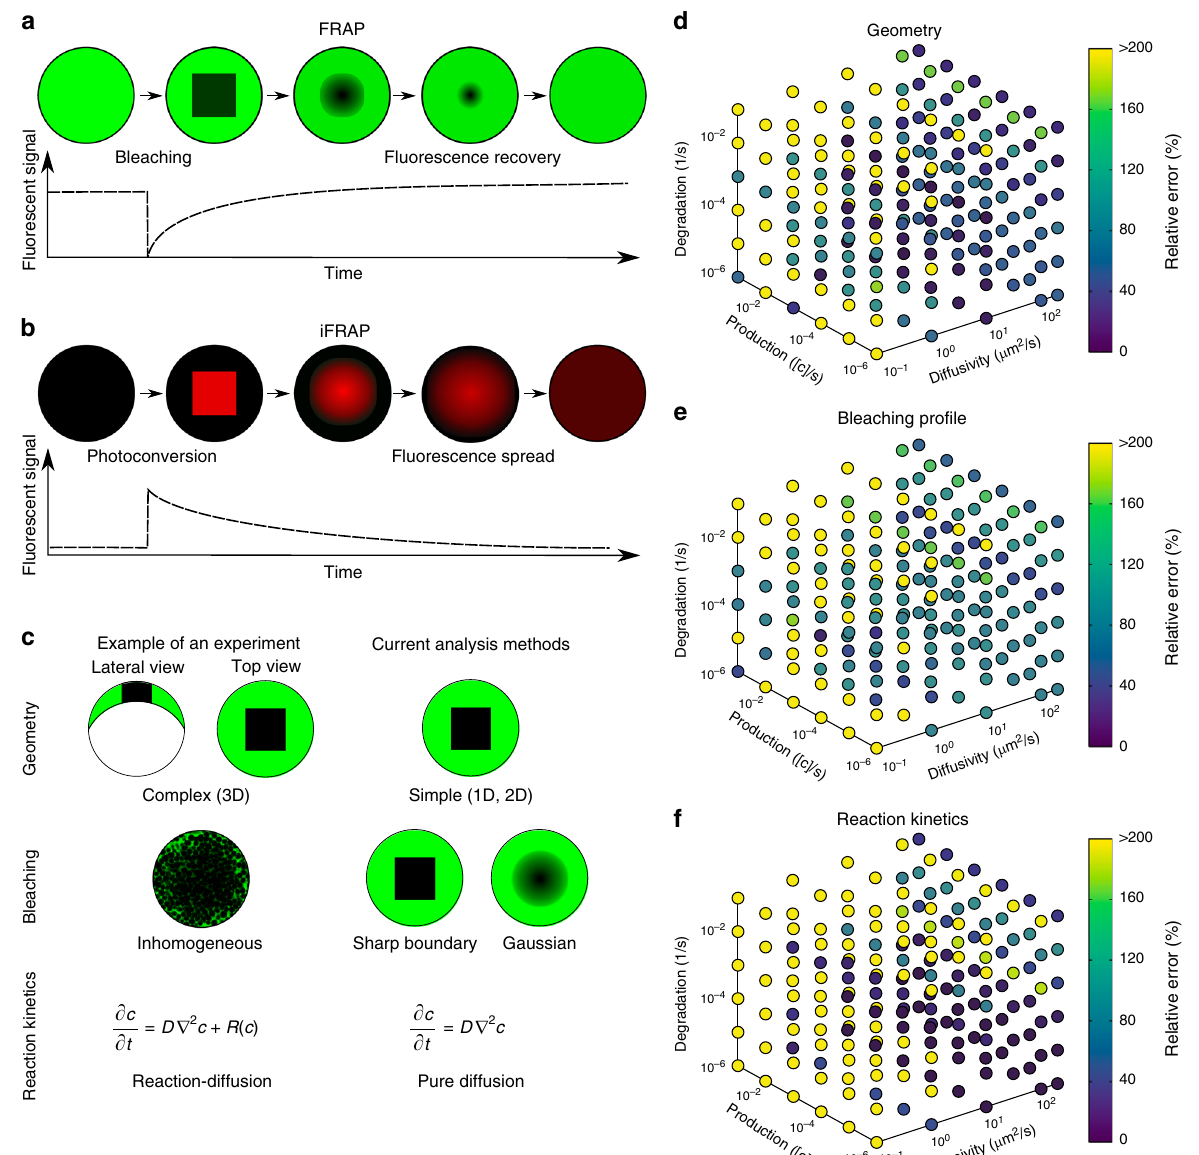
Fig. 1 Fluorescence perturbation techniques used for effective diffusion measurements, and drawbacks of current analysis methods. a In fl uorecence recovery after photobleaching (FRAP) experiments, a small region in the sample is bleached. After bleaching, the diffusion-driven recovery in the bleached region is monitored. b Inverse FRAP (iFRAP) is an experimental mirror image of FRAP: Molecules in a given region are photoconverted and then spread throughout the sample, resulting in the loss of fl uorescent signal in the region of photoconversion. c Drawbacks of current analysis methods exempli fi ed with zebra fi sh development at late blastula stages. Current analysis methods simplify sample geometry, idealise bleaching pro fi les, or ignore underlying bleaching conditions ( e ), or reaction kinetics ( f ), respectively. The maximum displayed error was capped to a value of 200%, but can be up to